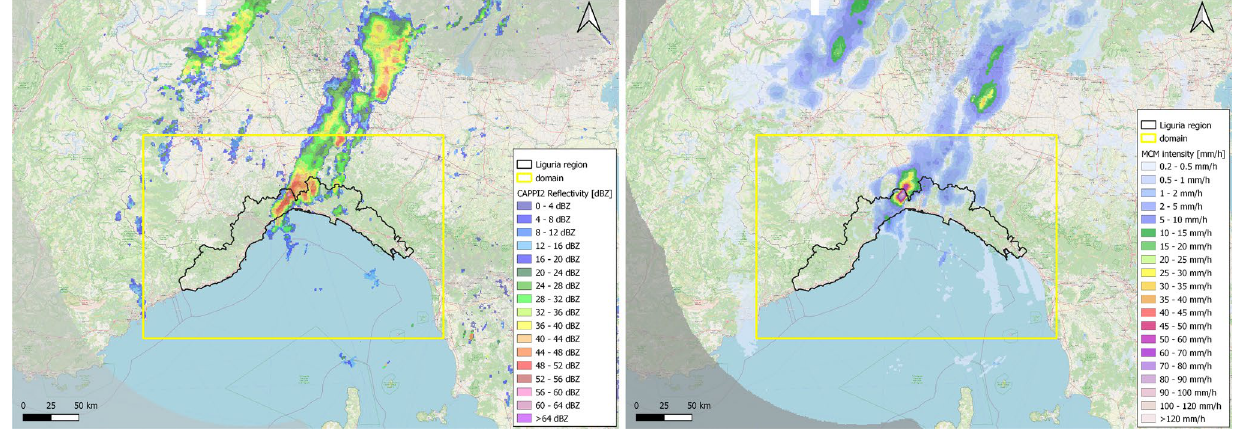
Figure 1. An example of a 2-km CAPPI reflectivity frame (left) and an MCM rain rate frame (right) (both referred to 21/10/2019 23:00 UTC); the selected area surrounding Liguria is delimited in yellow. The maps are downloaded from